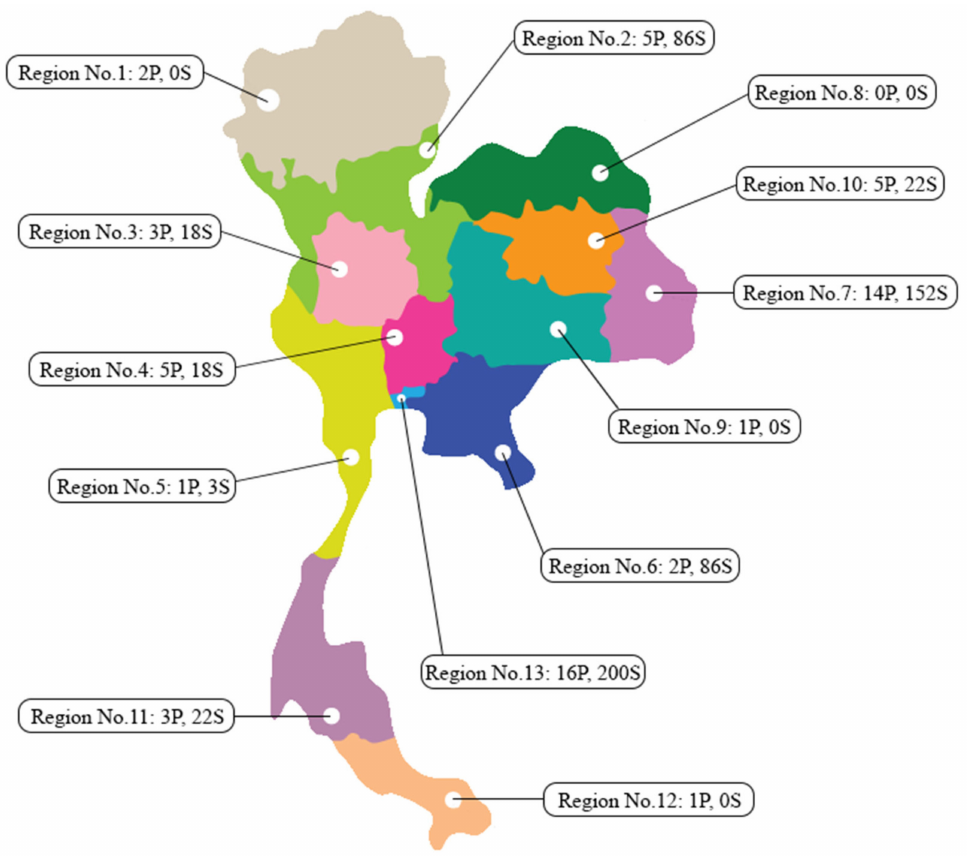
Figure 2. This figure shows the number of community pharmacies in this study covering 13 health regions, according to the National Health Security Office with the number of smokers who enter the community pharmacy smoking cessation program in each health region. For Example, Region No. 13: 16P, 200S is the health region number 13 had 16 participating community pharmacies, and had 200 smokers who experienced the community pharmacy smoking cessation